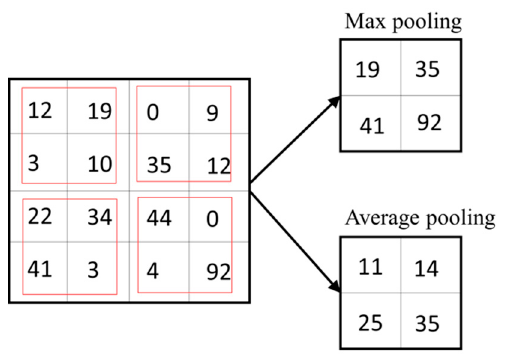
Figure 5. Types of pooling used in CNN.